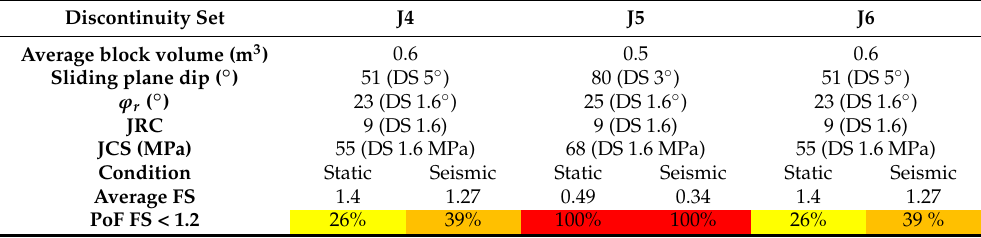
Table 10. Probabilistic stability analysis results for planar sliding: J4, J5, and J6 sets.